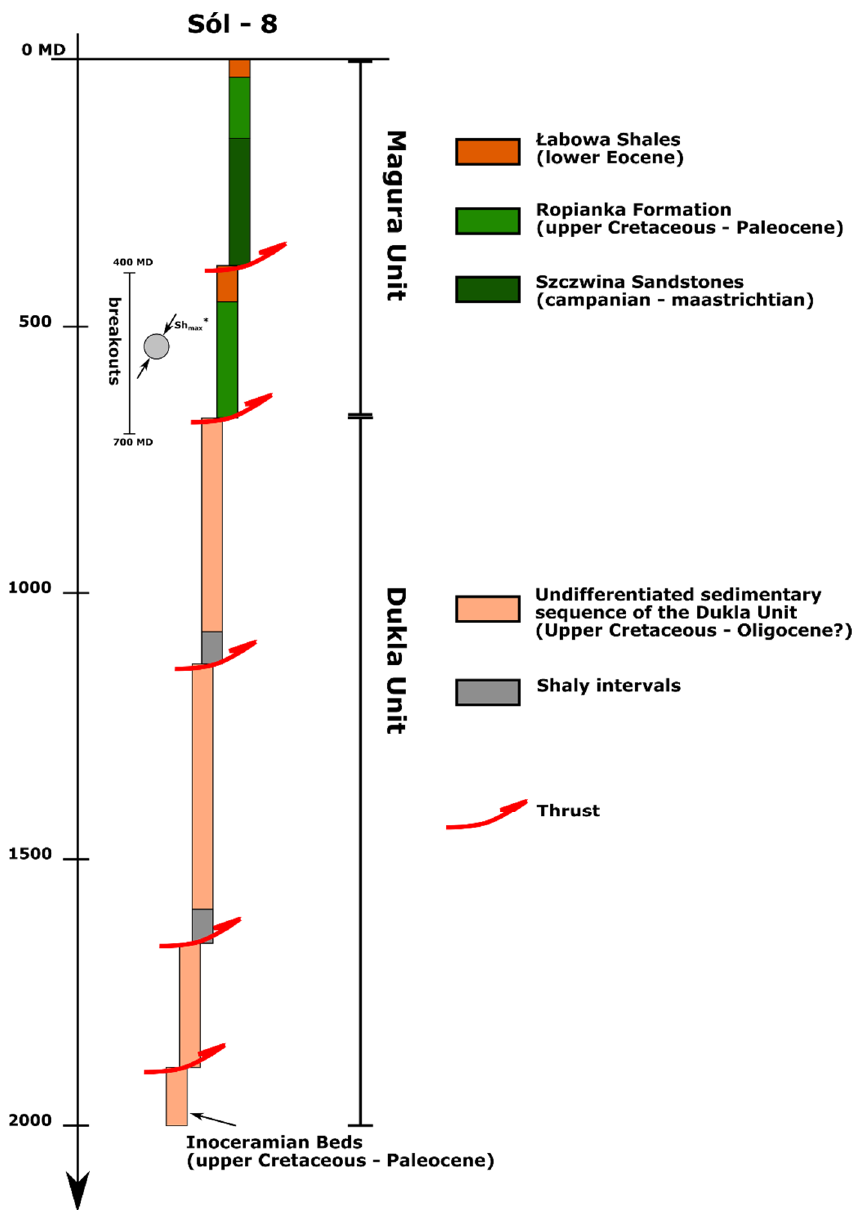
Figure 6. Stratigraphic profile of the Sól-8 borehole with simplified stratigraphic profile and thrust faults identified. *—approximate direction of the Sh max based on [77,78].